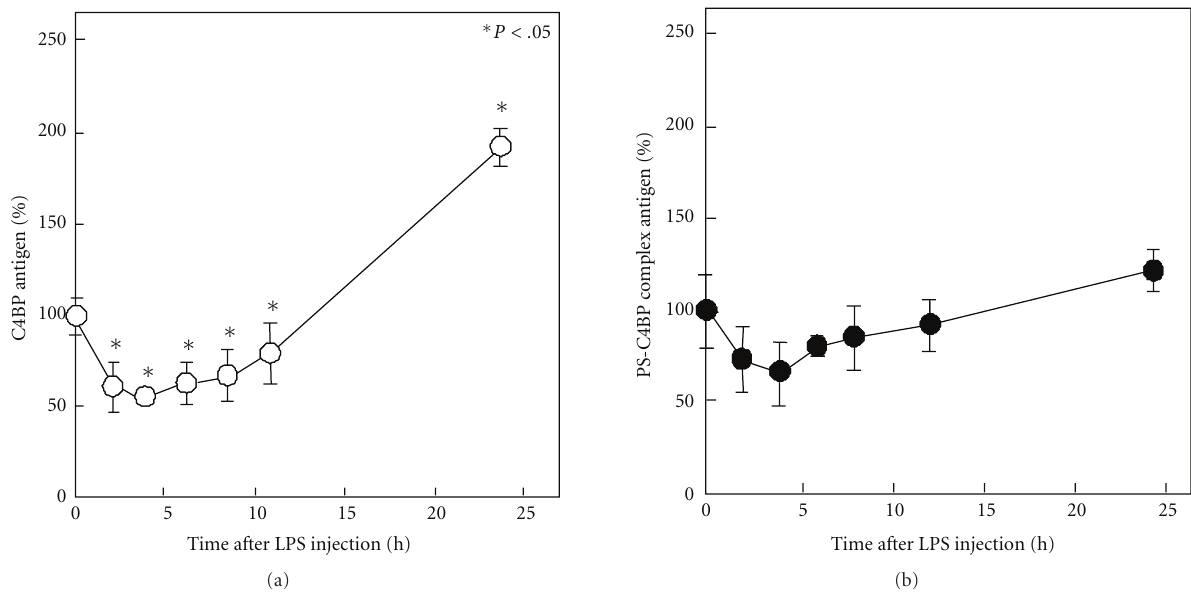
Figure 4: Changes in plasma levels of C4BP and PS-C4BP complex in LPS-treated rats . Citrated plasma was obtained from three rats treated with LPS intraperitoneally (2mg · kg − 1 ) at each time point to determine (a) plasma C4BP antigen levels and (b) plasma PS-C4BP complex antigen levels, as described previously in [31]. Data are expressed as the mean ± S.D. ( n = 3). ∗ P < . 05 versus time 0.